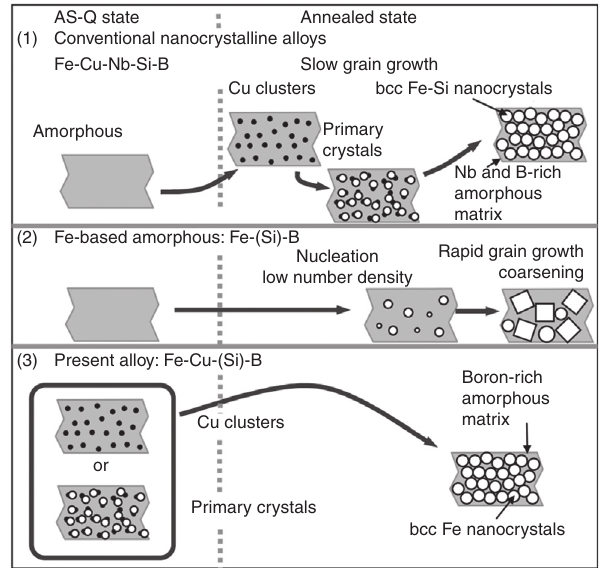
Figure 3 Schematic crystallization process of (A) conventional Fe- based nanocrystalline alloy (Fe-Cu-Nb-Si-B), (B) Fe-(Si)-B amorphous alloy, and (C) Fe-Cu-(Si)-B (Ohta and Yoshizawa [11] Copyright IOP